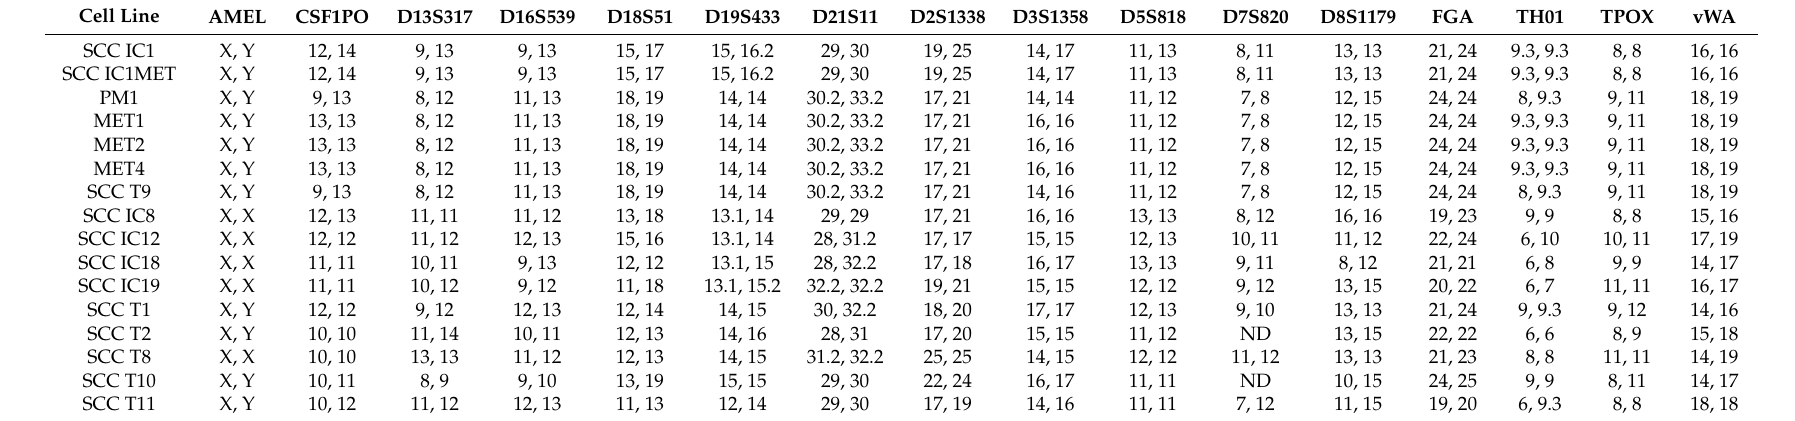
Table 2. Summary of short tandem repeat (STR) genotyping gives a characteristic genotype for the identification of individual cell